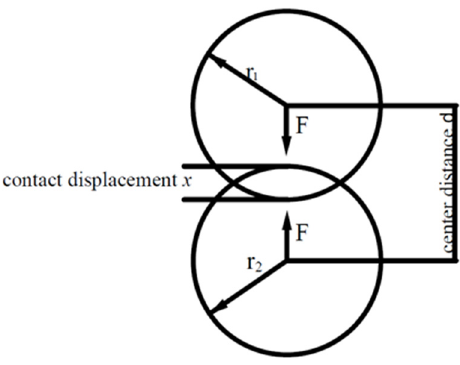
Figure 5. The contact process between two particles.